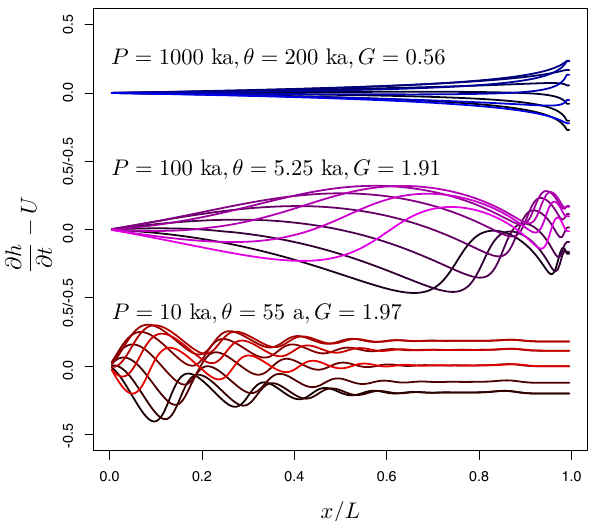
/U ) as a function Figure 3. Computed normalized erosion rate ( ∂h ∂t of the normalized distance ( x/L ) along the river profile for differ- ent values of the forcing period, P . Each curve in a given set cor- responds to a selected snapshot during a rainfall cycle. Top (blue) curves, middle (purple) curves and bottom (red) curves correspond to P = 1000, 100 and 10ka, respectively. n = 4, m = 2 and p = 2 in all three model